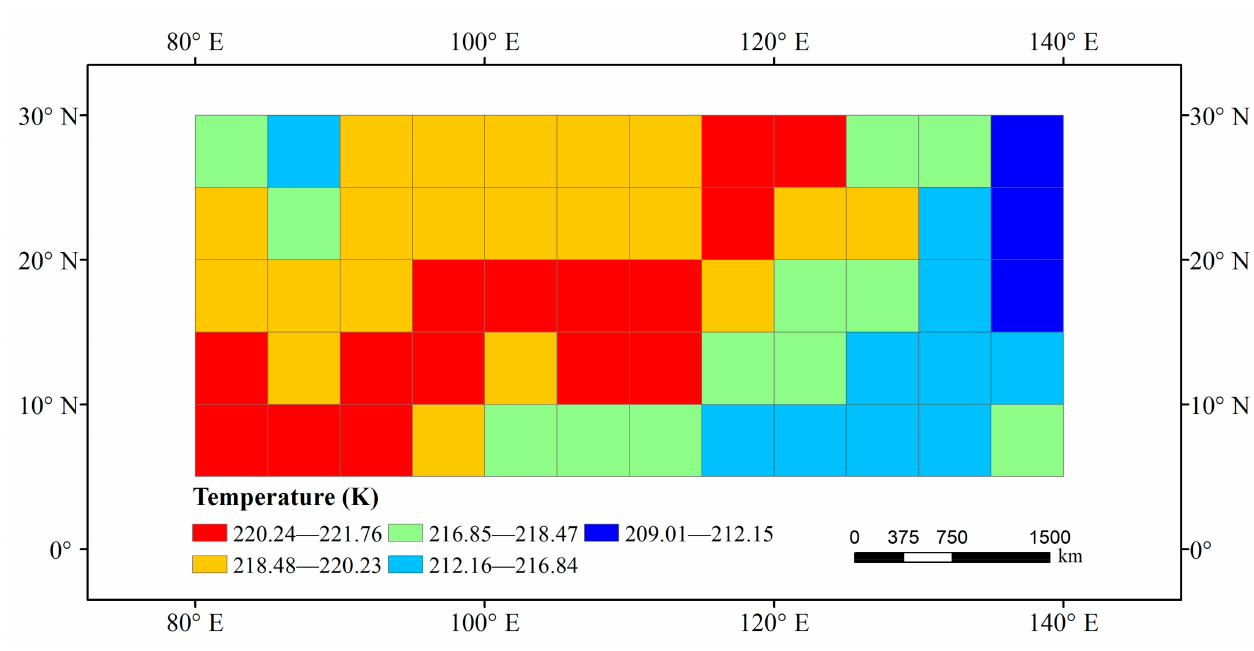
Figure 3. The average surface temperature during sol 81–111 from Martian years 29 to